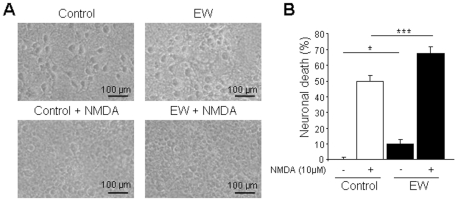
Ethanol withdrawal increases by 40% the sensitivity of neurons to excitotoxic injuries induced by NMDA (10 µM, 24 h) in cultured cortical neurons.(A) Phase-contrast photomicrographs show representative fields in the indicated conditions (Control, neurons not exposed to ethanol; EW, ethanol-withdrawn neurons). (B) Quantification of neuronal death. Values are means ± SEM (n = 17–20 wells/condition; N = 5 plates). Data were assessed by ANOVA test followed by Fisher's PLSD test (* P<0.05; *** P<0.001).